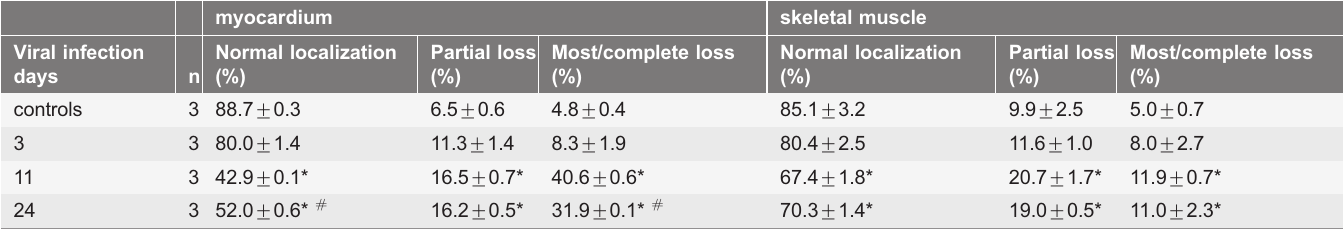
Table 5. The loss rate of mitochondrial membrane phospholipids in myocardium and skeletal muscle of VMC mice (mean ¡ SEM). myocardium skeletal